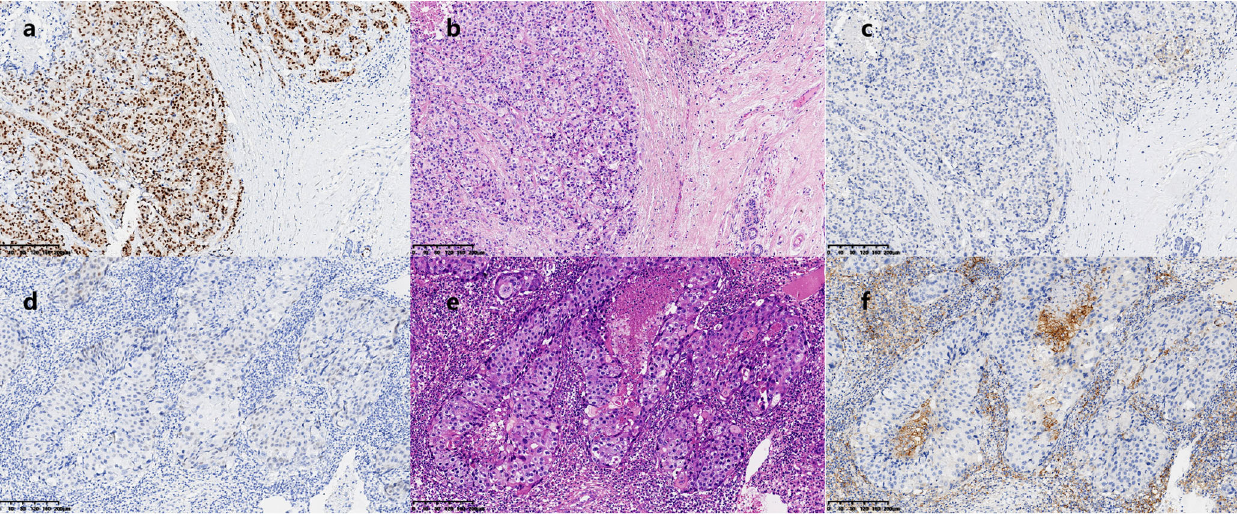
Fig. 5 Representative images of TILs and PD-L1 staining in the AR + and AR − cohorts (×100 magni fi cation). In the AR + cohort ( a ), the percentages of TILs ( b ) and the expression of PD-L1 ( c ) were low, and in the AR − cohort ( d ), the percentage of TILs ( e ) and the expression of PD-L1 ( f ) were high.